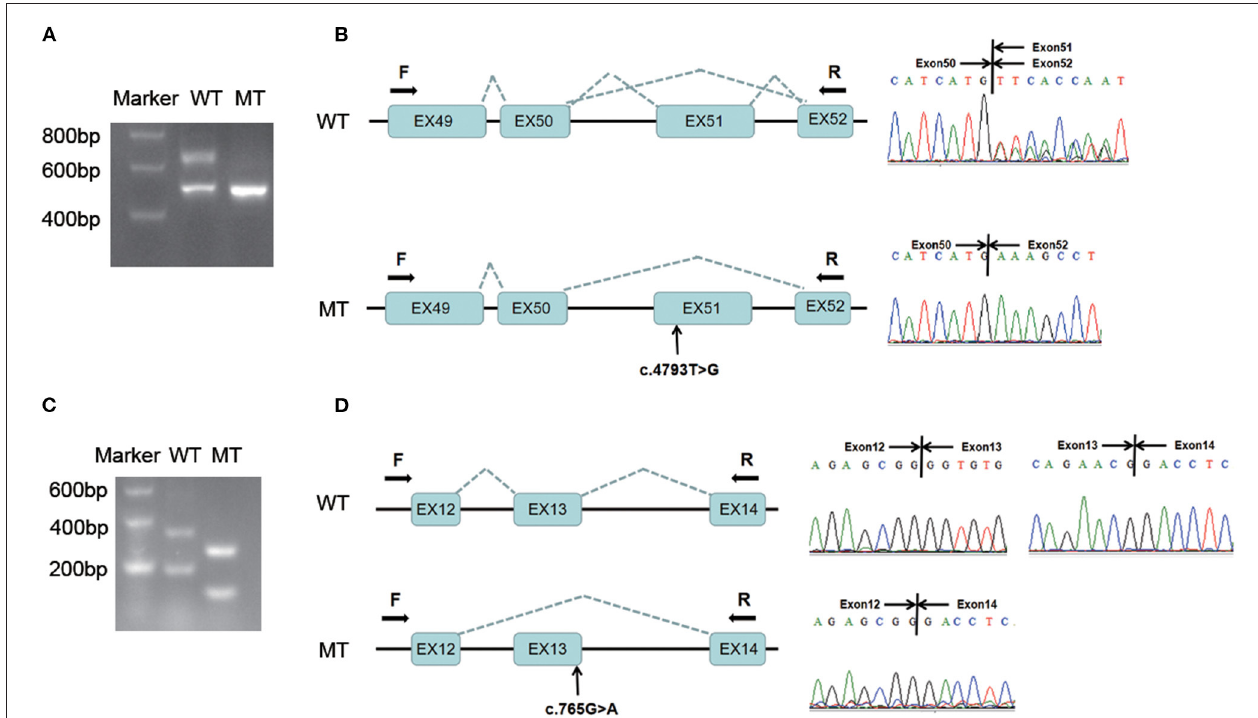
FIGURE 2 | Minigene assay analysis of two variants in COL4A3: c.4793T > G and c.765G > A. (A) The amplification products of the wild-type and variant minigene constructs ( COL4A3 : c.4793T > G) were separated by 2% agarose gel electrophoresis. The wild-type transcription product had two bands, while the variant transcription product exhibited only one band after PCR amplification. (B) Direct sequencing of the PCR products showed that there were two alternative splicing transcripts exon51 + /exon51– in the wild-type minigene constructs, while the variant transcript skipped exon 51 during the splicing process. (C) The amplification products of the wild-type and variant minigene constructs (c.765G > A) were separated by 2% agarose gel electrophoresis. Although the wild-type and variant transcription products exhibited two bands after PCR amplification, the variant transcripts were all shorter than those of the wild-type. (D) Direct sequencing of the PCR products revealed that the two variant transcripts all skipped exon 13 during the splicing process. WT, wild-type; MT, mutant-type. F, forward primer; R, reverse